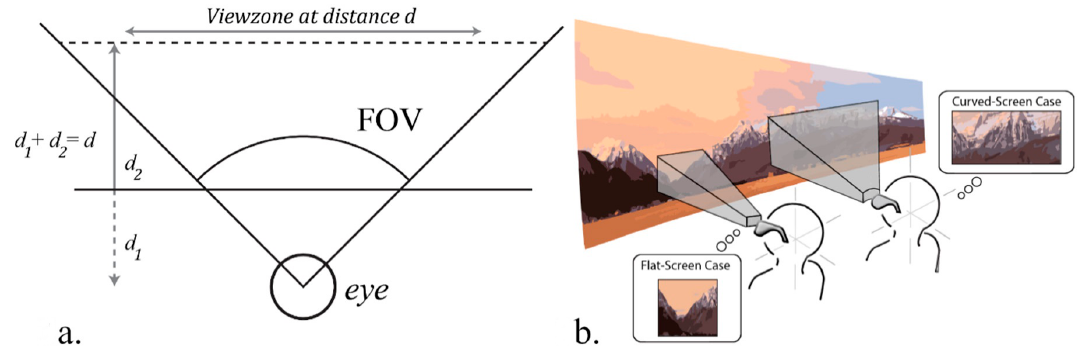
Figure 3. ( a ) Viewzone is defined by a viewable radial length at some distance, d; field of view (FOV) is the angle of information accessible by the eye. ( b ) The goal of this paper is to improve the FOV by curving the device’s active region. This will allow the user to see a greater viewzone.